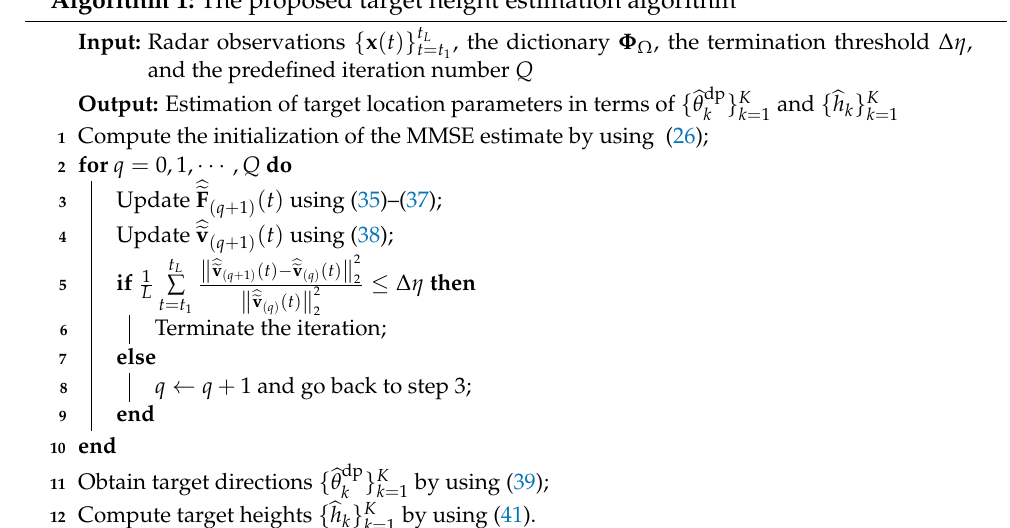
Algorithm 1: The proposed target height estimation